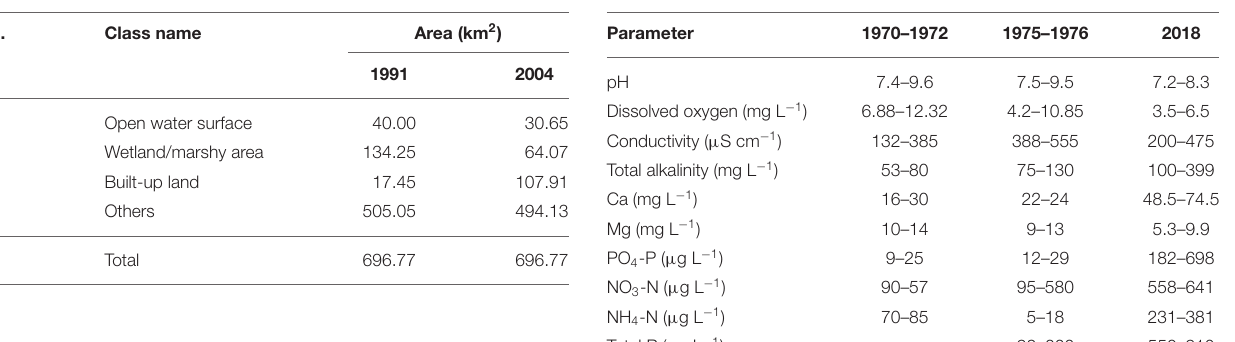
TABLE 2 | Long-term water quality changes in Anchar Lake (Source: Kaul, 1977; Kaul et al., 1978; Farooq et al.,